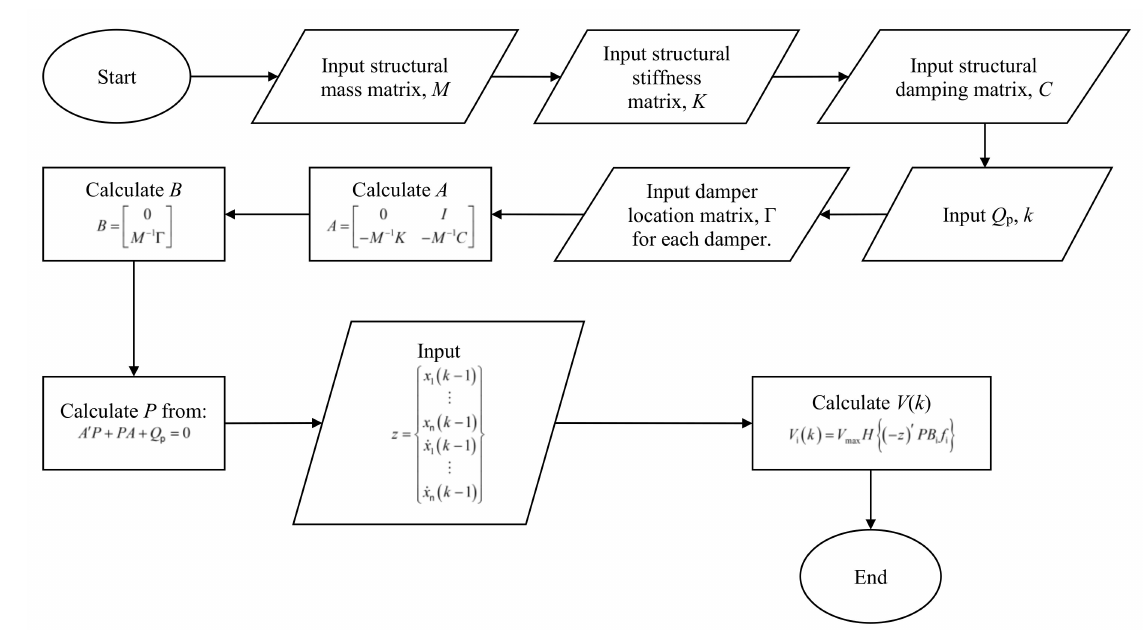
Figure 2. Flowchart for simulating Lyapunov control algorithm.